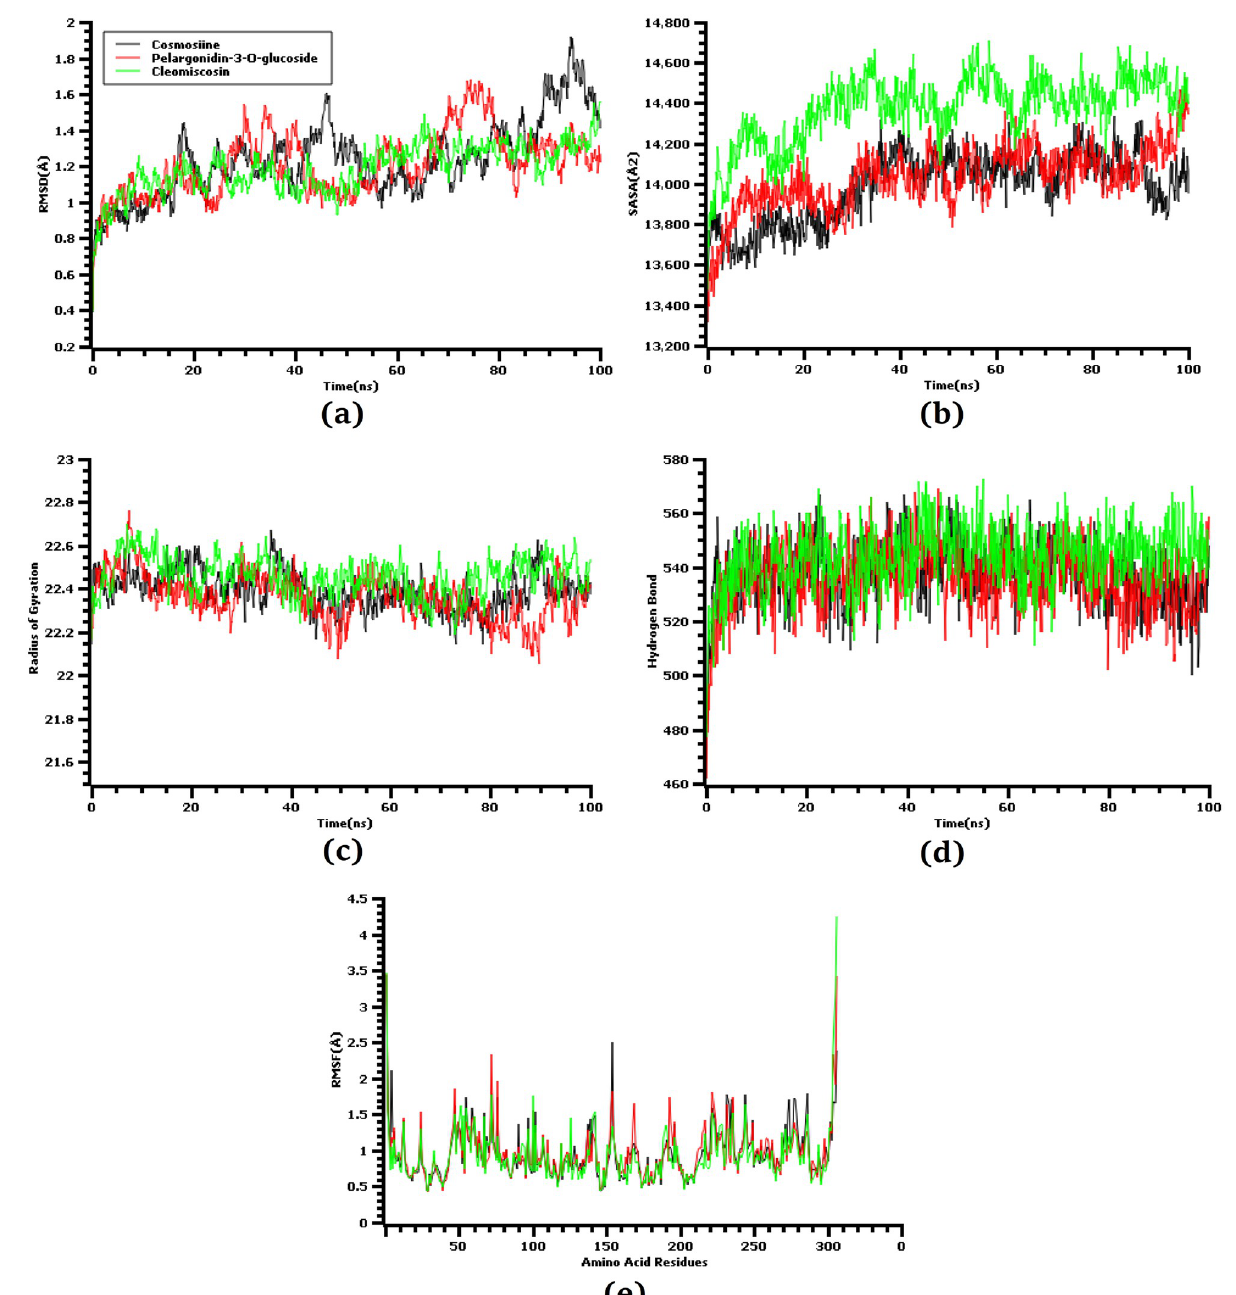
Fig 3. Time kinetics analysis of all the simulated systems. The alphabetical orders from (a) to (e) indicate RMSD analysis of the alpha carbon atoms (a), protein volume with expansion analysis (b), degree of rigidity and compactness analysis (c), hydrogen bond analysis (d), and flexibility analysis of amino acid residue